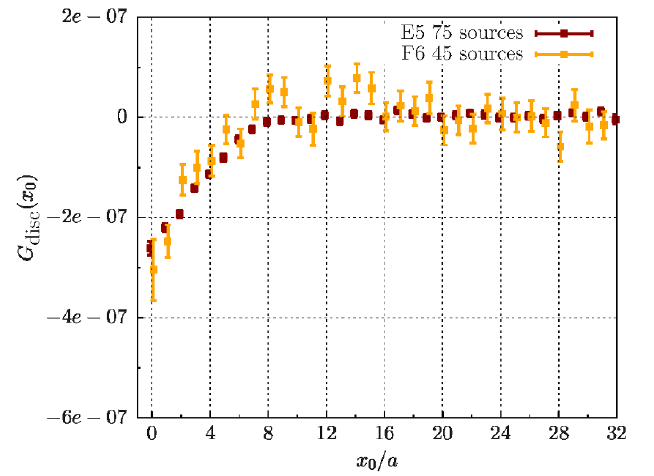
Figure 6 . The quark-disconnected contribution G disc ( x 0 ) to the vector correlator (in lattice units) computed on ensembles E5 and